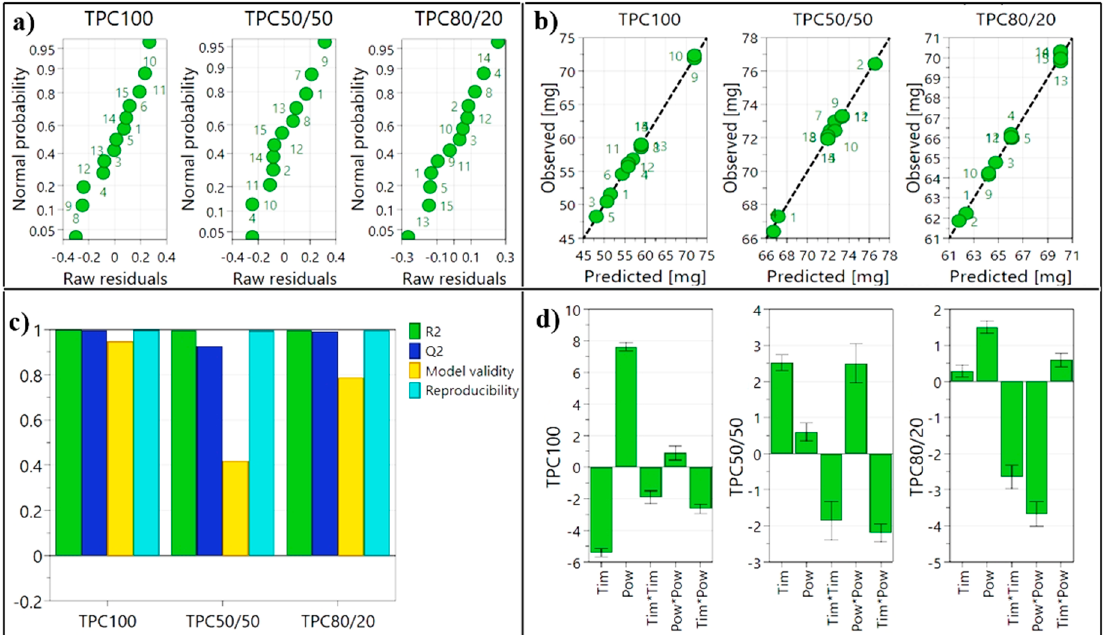
Figure 1. Graphical summary of ( a ) residuals normal probability; ( b ) observed vs. predicted ( c ) summary of fit; ( d ) scaled and centered coefficients (TPC100—total phenolic content in extracts obtained with water 100%, TPC50/50—total phenolic content in extracts obtained with ethanol–water 50:50, TPC80/20—total phenolic content in extracts obtained with ethanol–water 80:20).